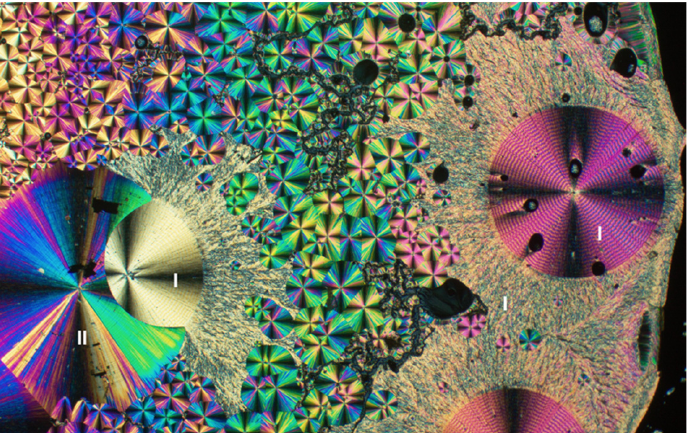
Figure 6. Thin film of thiacloprid crystals grown by cooling its melt, as viewed between crossed polarizers. Form I presents as banded spherulites and a chaotic texture, Form II as smooth spherulites.